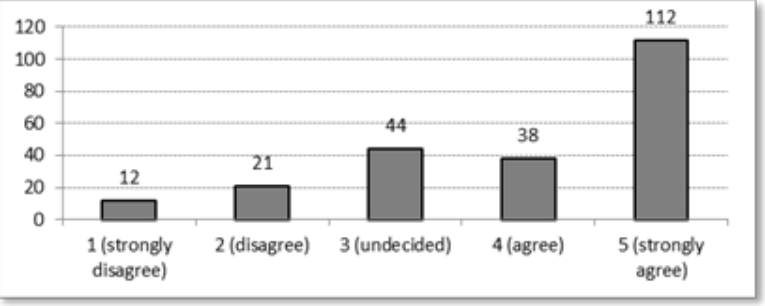
Figure 12. Degree of agreement with the following statement: “access anywhere at any time is an advantage of e-learning” (absolute numbers). Valid answers: